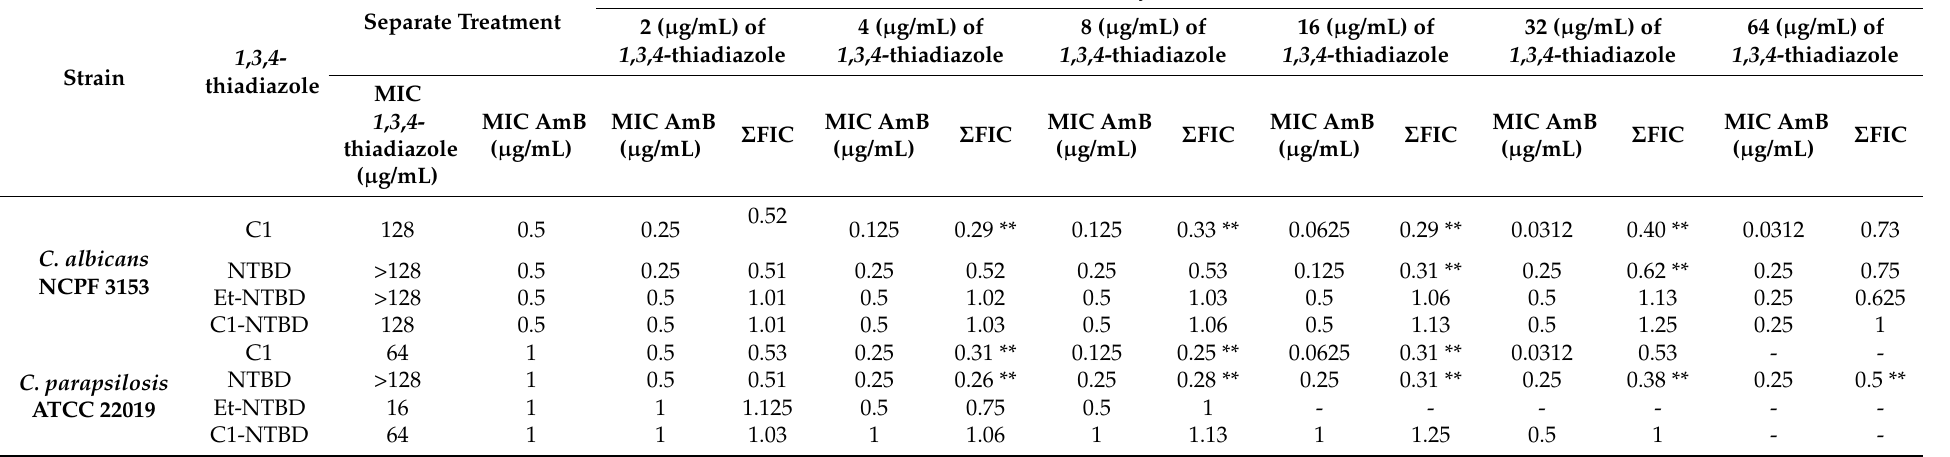
Table 1. Interactions between 1 , 3 , 4 -thiadiazoles (C1, NTBD, Et-NTBD, and C1-NTBD) and amphotericin B (AmB) in terms of activity against reference strains in vitro after 48-h incubation: MIC—minimal inhibiting concentration of the compound, ∑ FIC—coefficient, which is the sum of partial concentrations inhibiting the growth of the pathogens. The interactions were determined based on the specified ranges: synergy ( ∑ FIC ≤ 0.5), indifferent ( ∑ FIC ≥ 0.5 to 4), antagonism ( ∑ FIC > 4); ** =